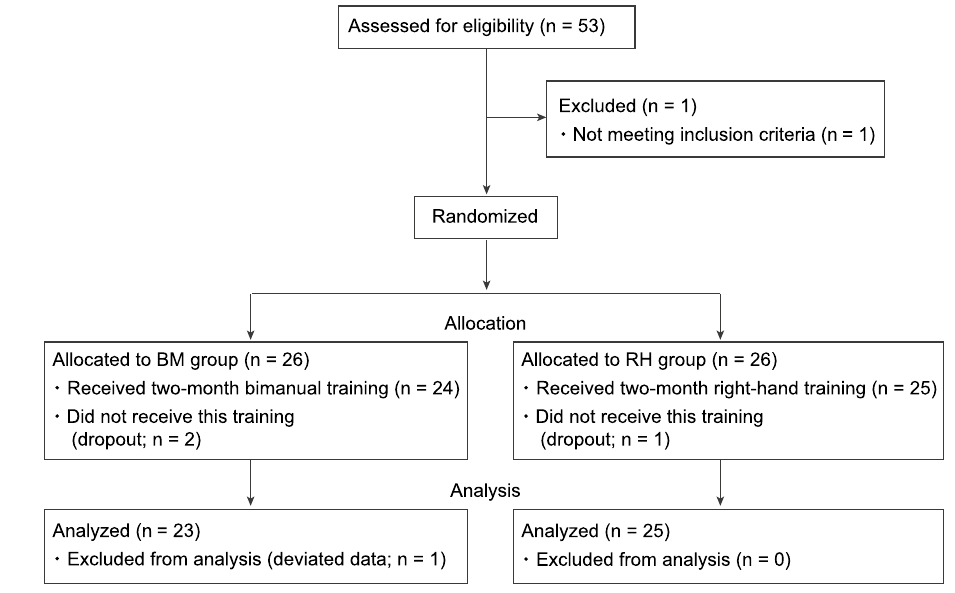
Figure 1. An experimental flow chart in the present